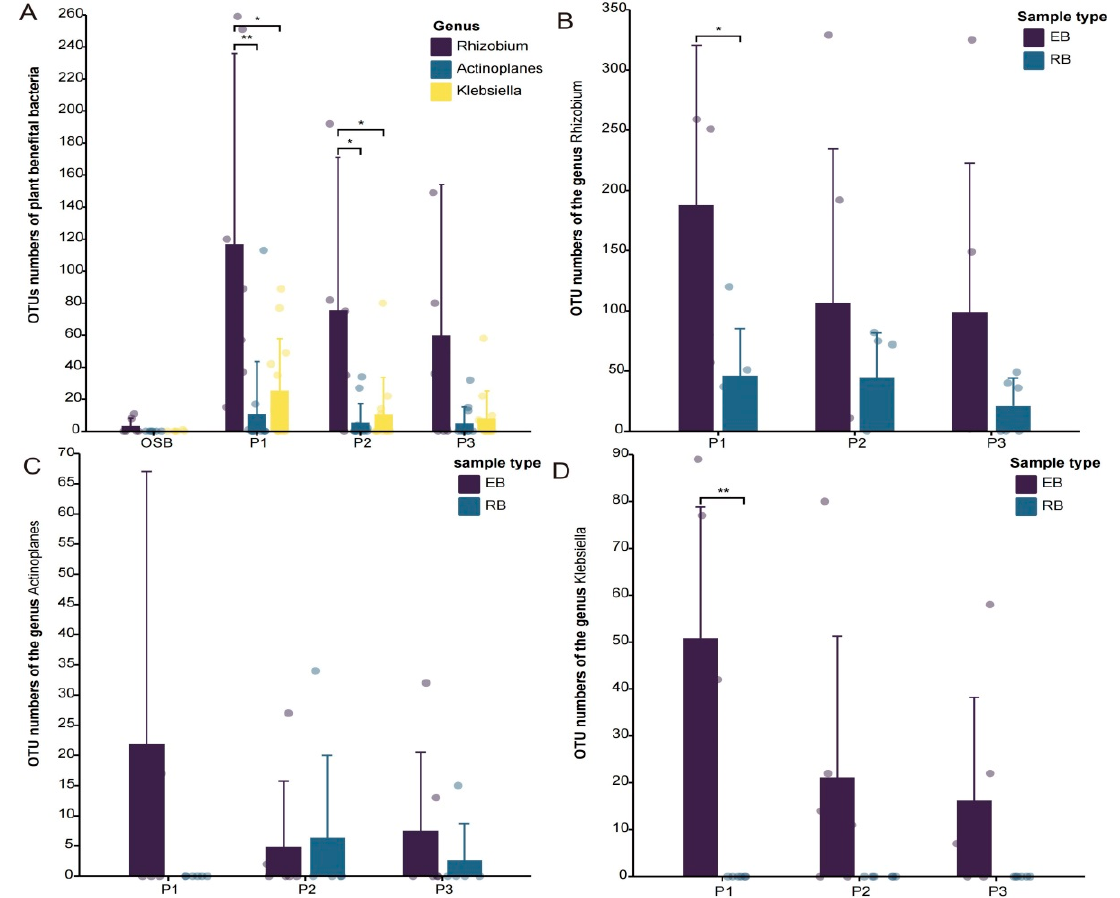
Figure 9. ( A ) The differences in plant beneficial bacteria related to three different halophytes and OSB; ( B ) OTU numbers of the genus Rhizobium associated with three different halophytes and ecological niches; ( C ) OTU numbers of the genus Actinoplanes associated with three different halophytes and ecological niches; ( D ) OTU numbers of the genus Klebsiella associated with three different halophytes and ecological niches. * p < 0.05; ** p < 0.01.